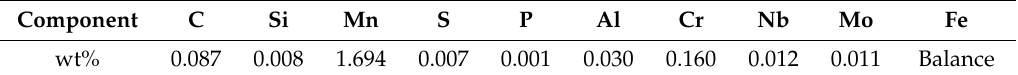
Table 1. Chemical compositions of base metal (wt.%).